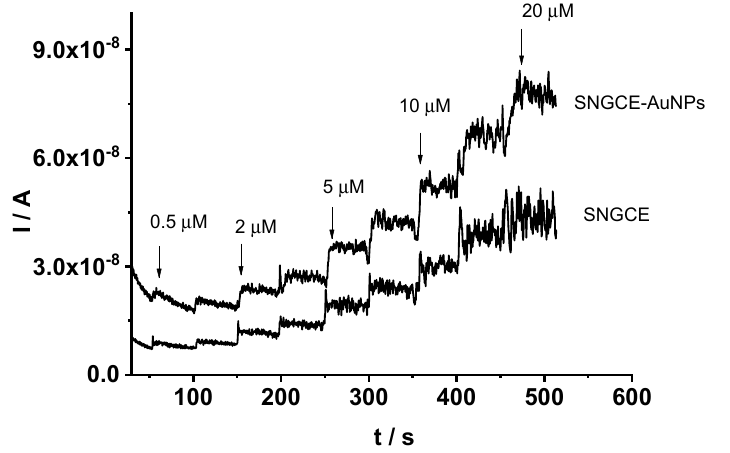
Figure 7. Chronoamperograms recorded at SNGCE and SNGCE/AuNPs in 0.1 M PBS of pH 7 containing different MEL concentrations: 0.5, 1, 2, 3, 5, 7, 10, 15, and 20 µM. E appl = 0.70 V.